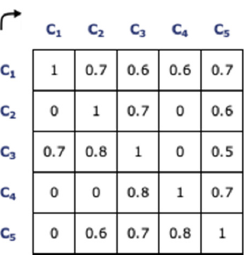
Figure A2. Matrix with a valuation of incidences among causes.